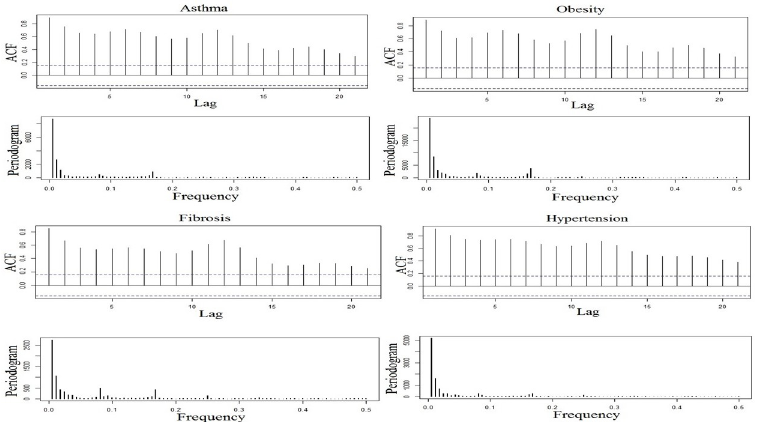
Fig 11. Autocorrelation and periodicity of four group 1 diseases for the monthly collected RSV from Jan 2004– Dec 2016 with obesity as the benchmark disease. Observed data is showing a cyclic pattern in autocorrelation above significant line (dotted) and six months periodicity in all and three months in asthma as well as hypertension (periodogram).